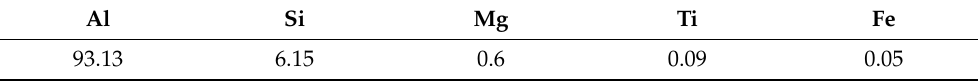
Table 1. AlSi7Mg0.6 powder composition: mass fraction per alloying